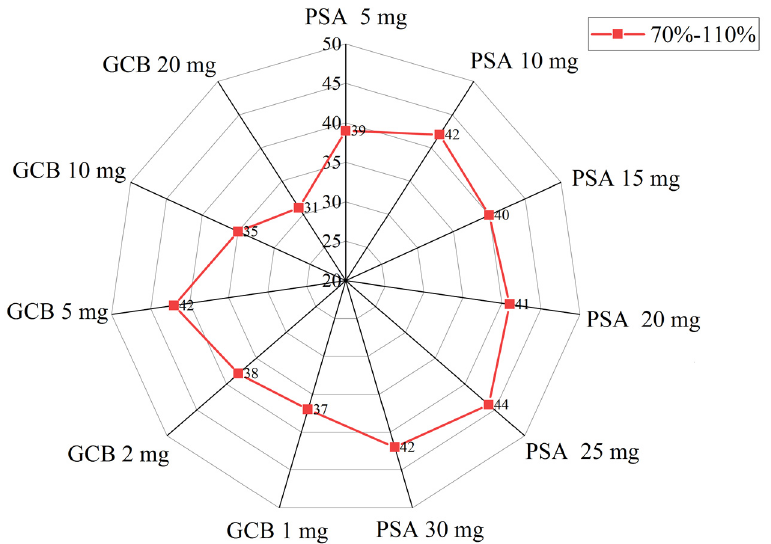
Figure 1. Recovery results for different amounts of sorbent during the purification process (70%– 110%).